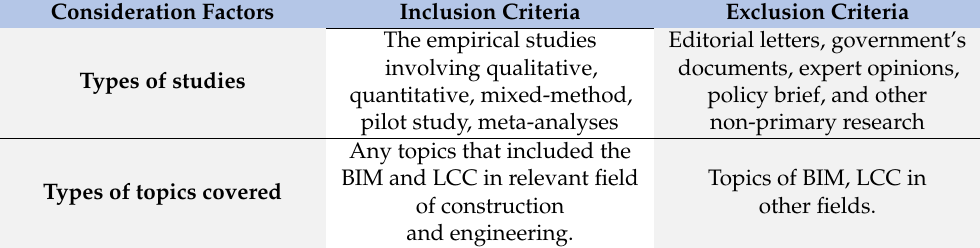
Table 1. Inclusion and exclusion